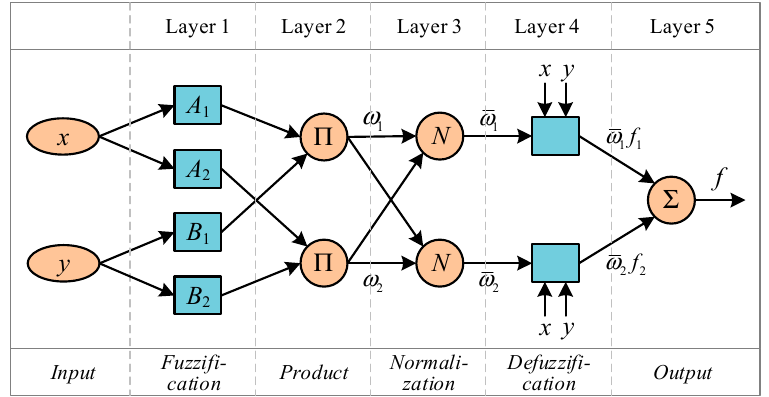
Figure 2. General architecture of the neural fuzzy inference system (NFIS) model.